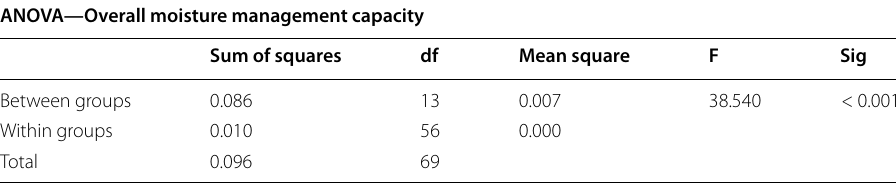
Table 5 The one-way ANOVA test of overall moisture management capacity ANOVA—Overall moisture management capacity Sum of squares df Mean square F Sig Between groups Within groups